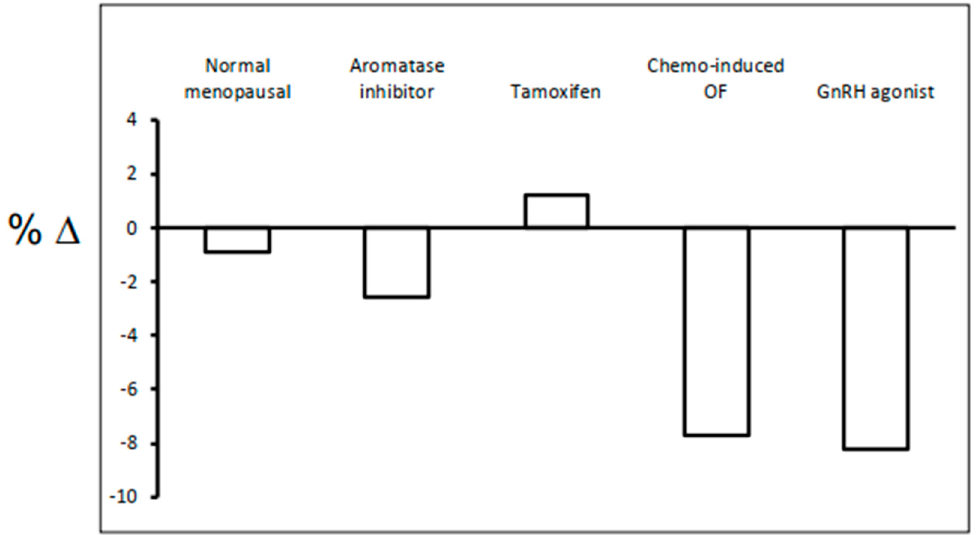
Figure 2. Bone loss (percentage change) at 12 months in lumbar spine with breast cancer treatments.